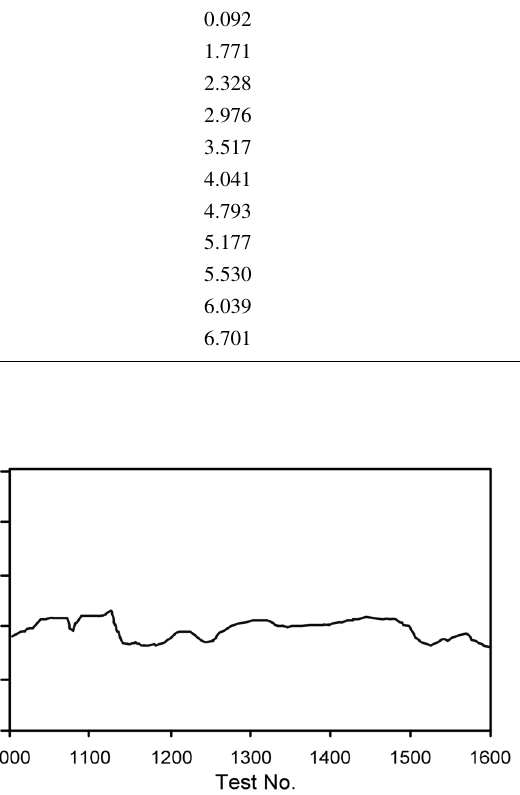
Fig. 5 Two-phase flow velocity when standard gas output is 2.976 m 3